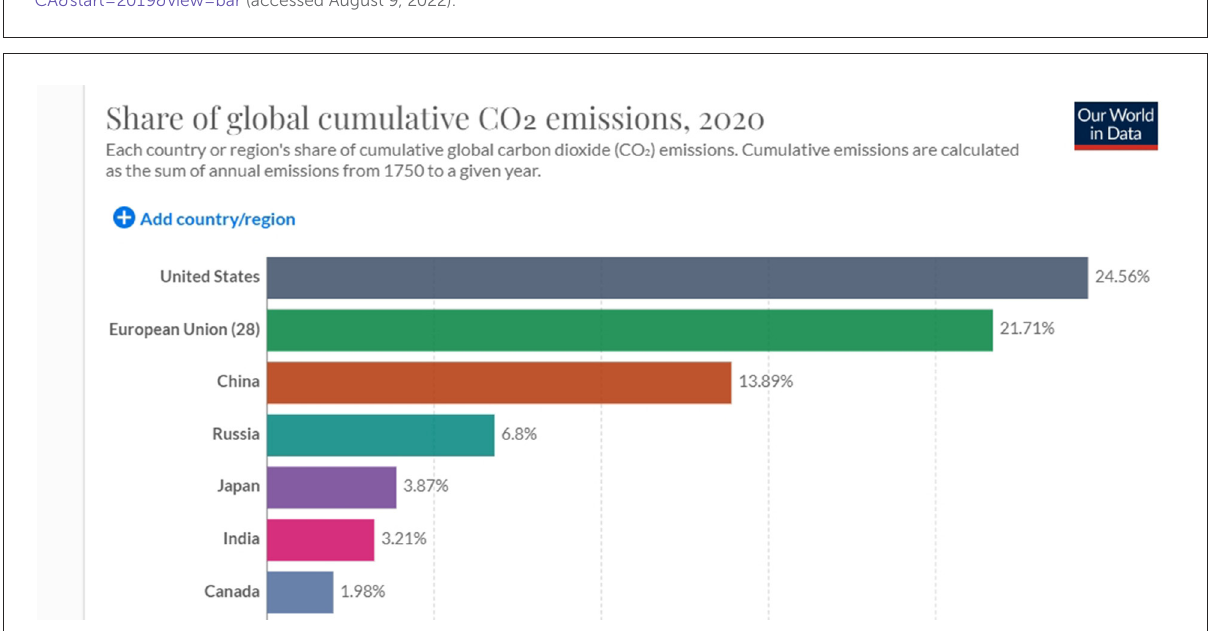
used by these stateless nations for their political, rather than environmental, goals (i.e., political autonomy). Another work by Conversi stressed the importance of what he called “exemplary